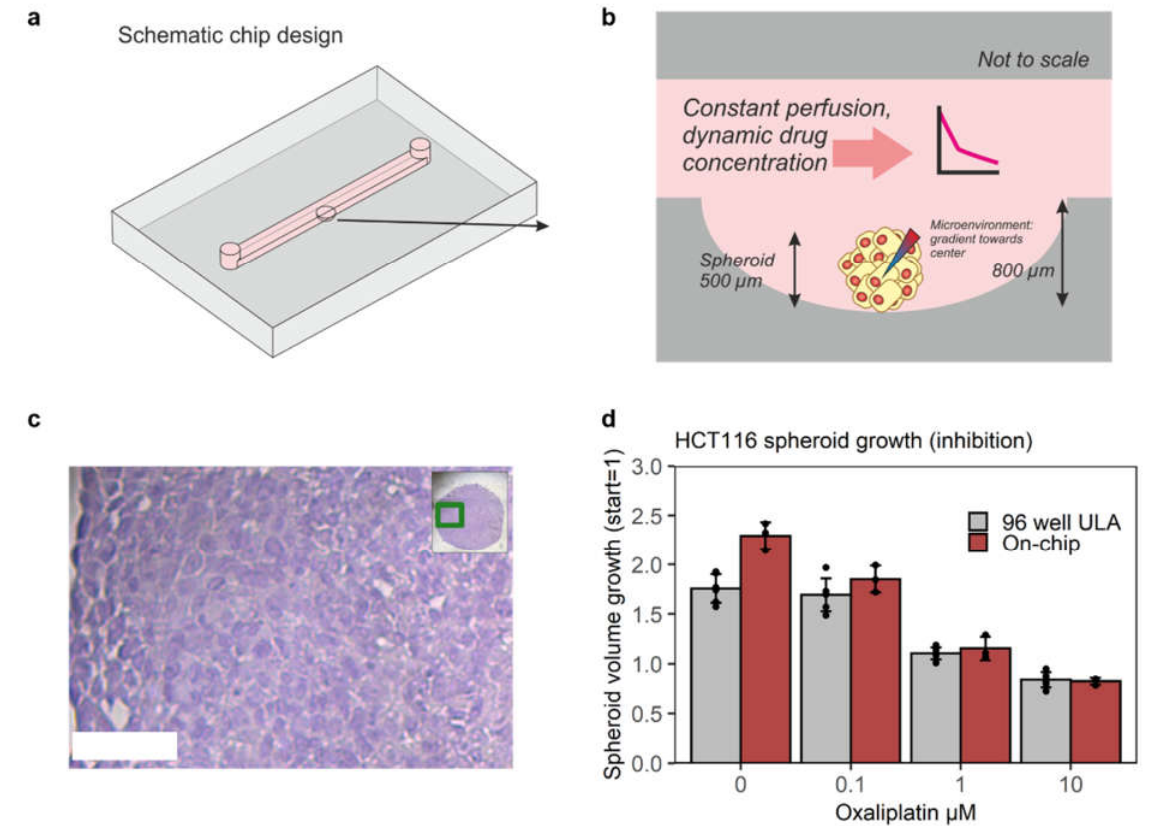
Figure 1. Design and validation of the chip system for mimicking oxaliplatin efficacy in a HCT116 xenograft model. ( a , b ) Chip design. The two-part chip consists of a 21 × 2 × 1 mm (l × w × h) top channel for continuous perfusion and dynamic drug concentrations and a U-shaped well for spheroid placement and growth. ( c ) H&E staining shows low differentiation and little extracellular matrix in the spheroid on-chip, as in HCT-116 xenografts. Scale bar = 50 µm. ( d ) Growth inhibition after 48 h exposure to constant concentrations of oxaliplatin is not confounded by the chip, although control growth is slightly higher, as shown by comparison to a 96-well ultralow-attachment (ULA) plate; n = 3 spheroids for on-chip, n = 6 spheroids for 96 well; error bars represent the standard deviation (SD).